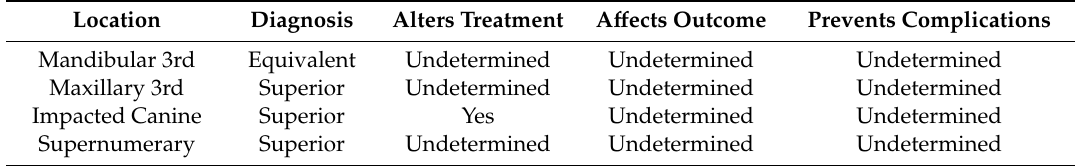
Table 1. Comparison of Cone Beam Computed Tomography to Panoramic Imaging in Dentoalveolar Surgery.